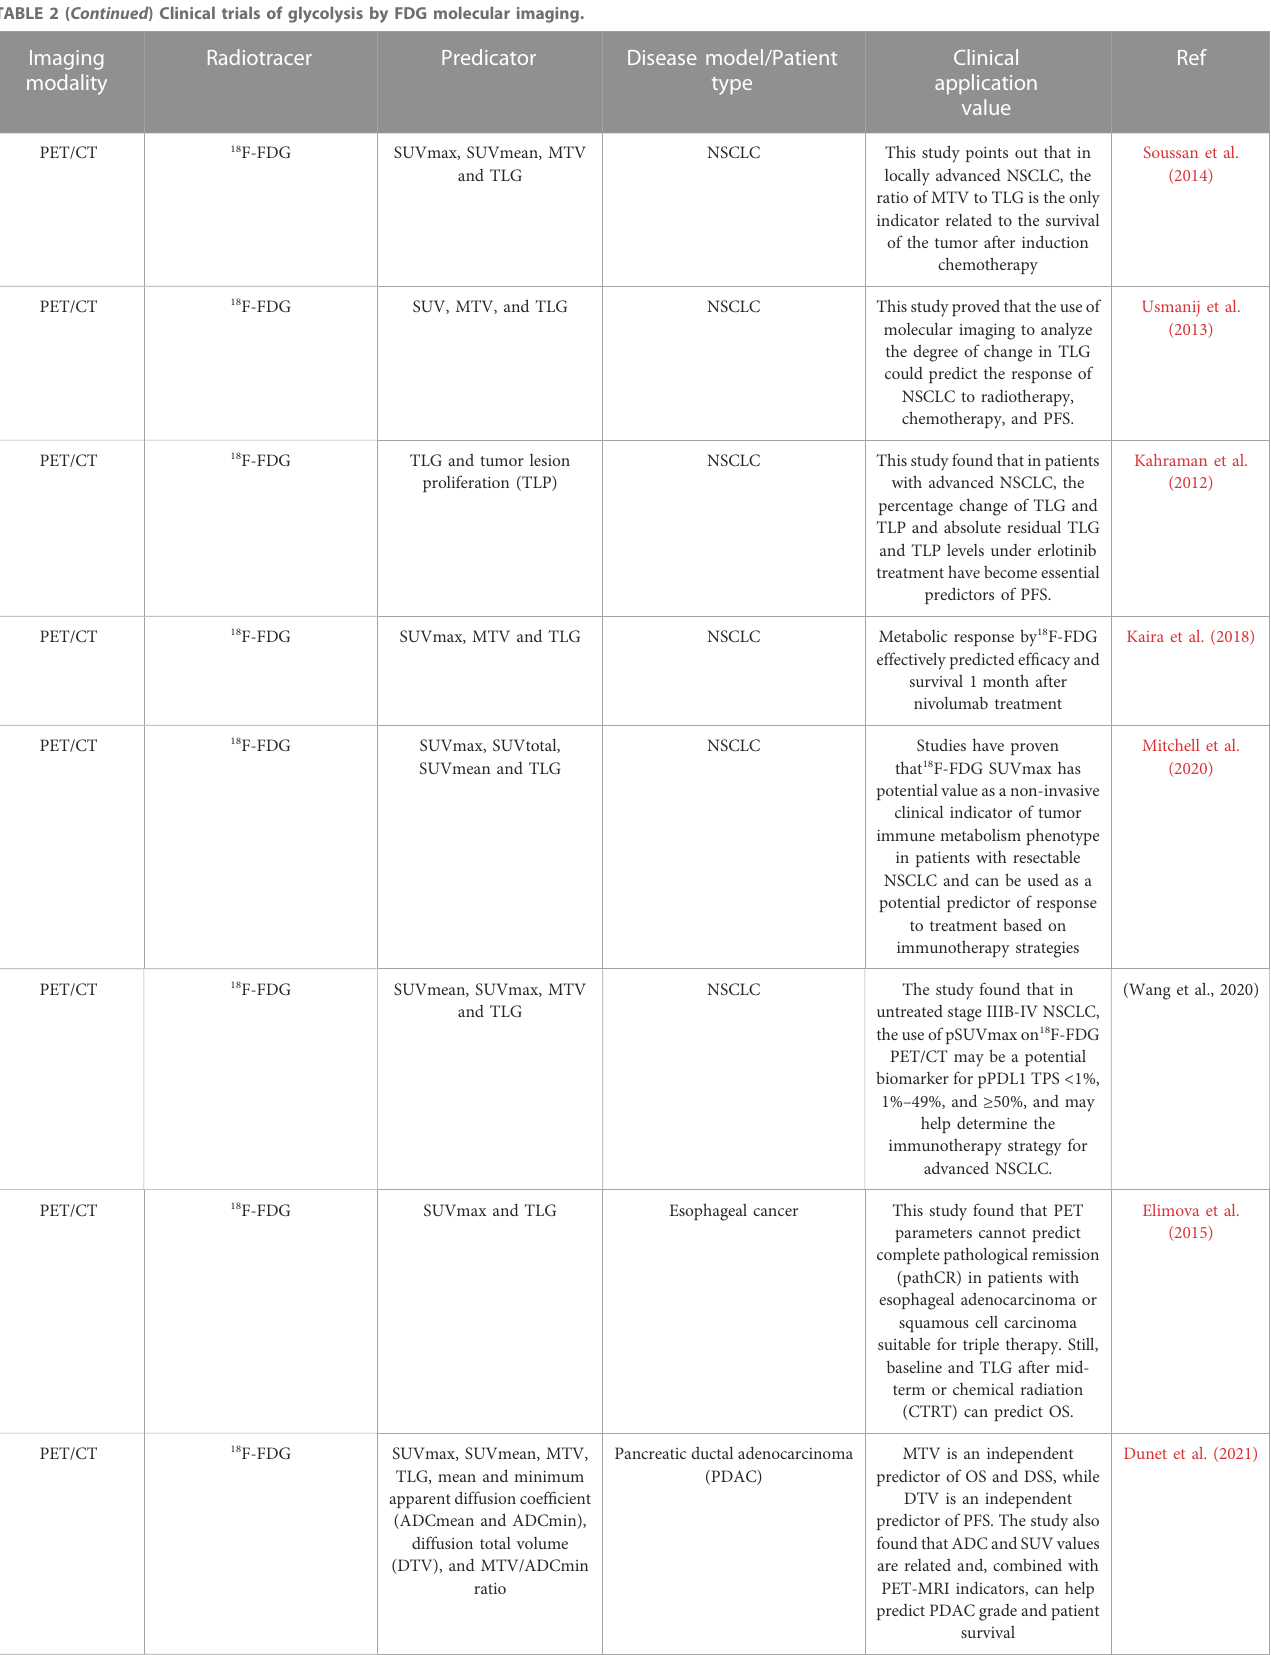
TABLE 2 ( Continued ) Clinical trials of glycolysis by FDG molecular